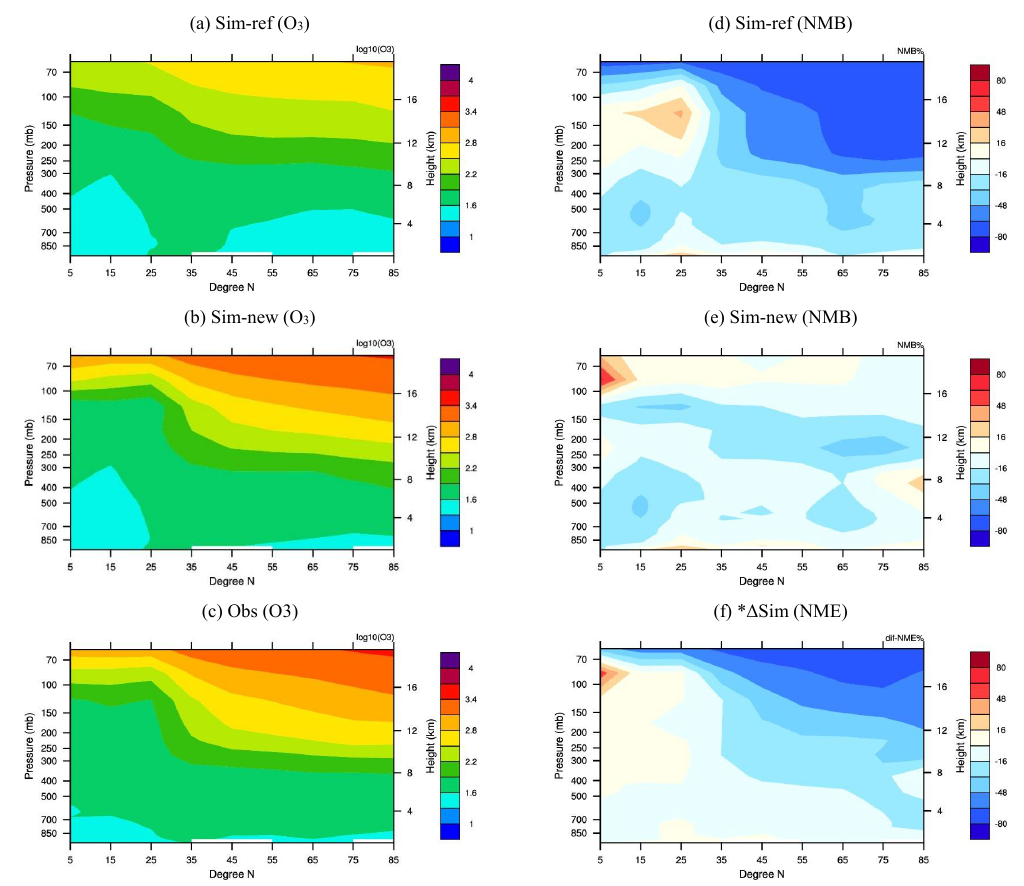
Figure 5. Zonal mean profiles of ozone and error metrics for the different cases. (a) Simulated ozone profile in reference case; (b) simulated ozone profile in new case with updated O 3 -PV parameterization; (c) observed ozone profile, the annual mean of measurement time period for each WOUDC site across the Northern Hemisphere; (d) normalized Mean Bias in the reference simulation; (e) normalized Mean Bias in the new simulation with updated O 3 -PV parameterization; (f) difference in Normalized Mean Errors between the new simulation and reference simulation (unit: ppb, 2006 January–December; NMB- Normalized Mean Bias; NME-Normalized Mean Error; * (cid:49) Sim = Sim-new minus Sim-ref in